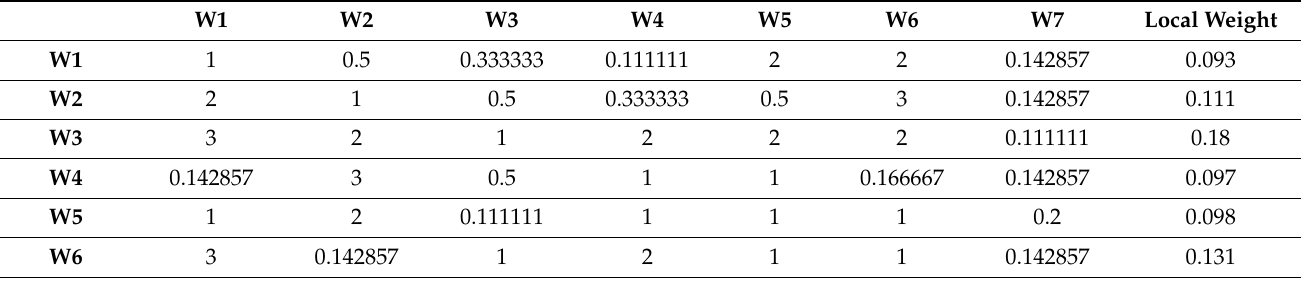
Table 11. Pairwise matrix for “Weaknesses”